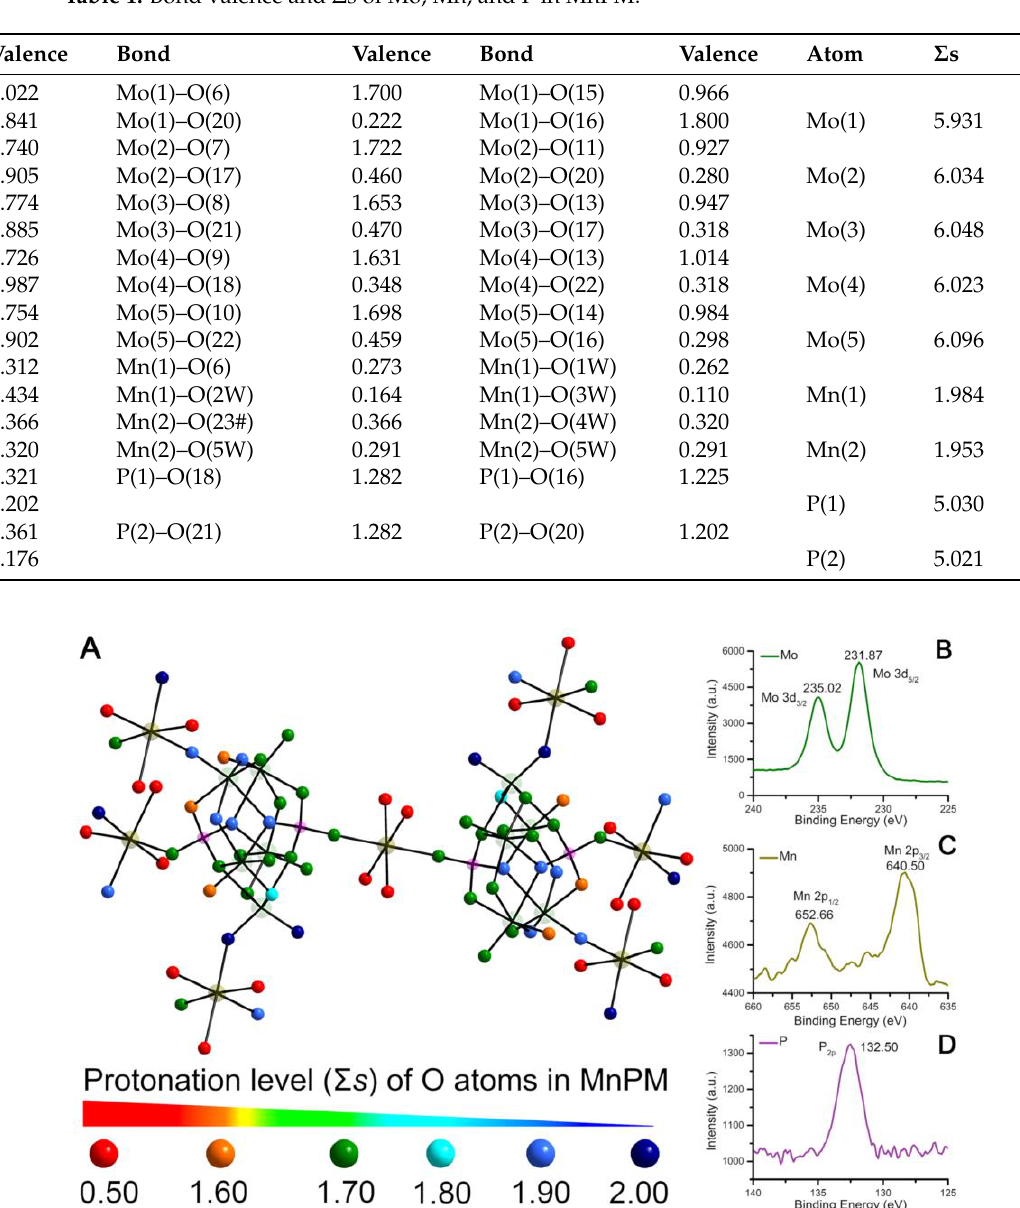
Table 1. Bond valence and Σ s of Mo, Mn, and P in MnPM.